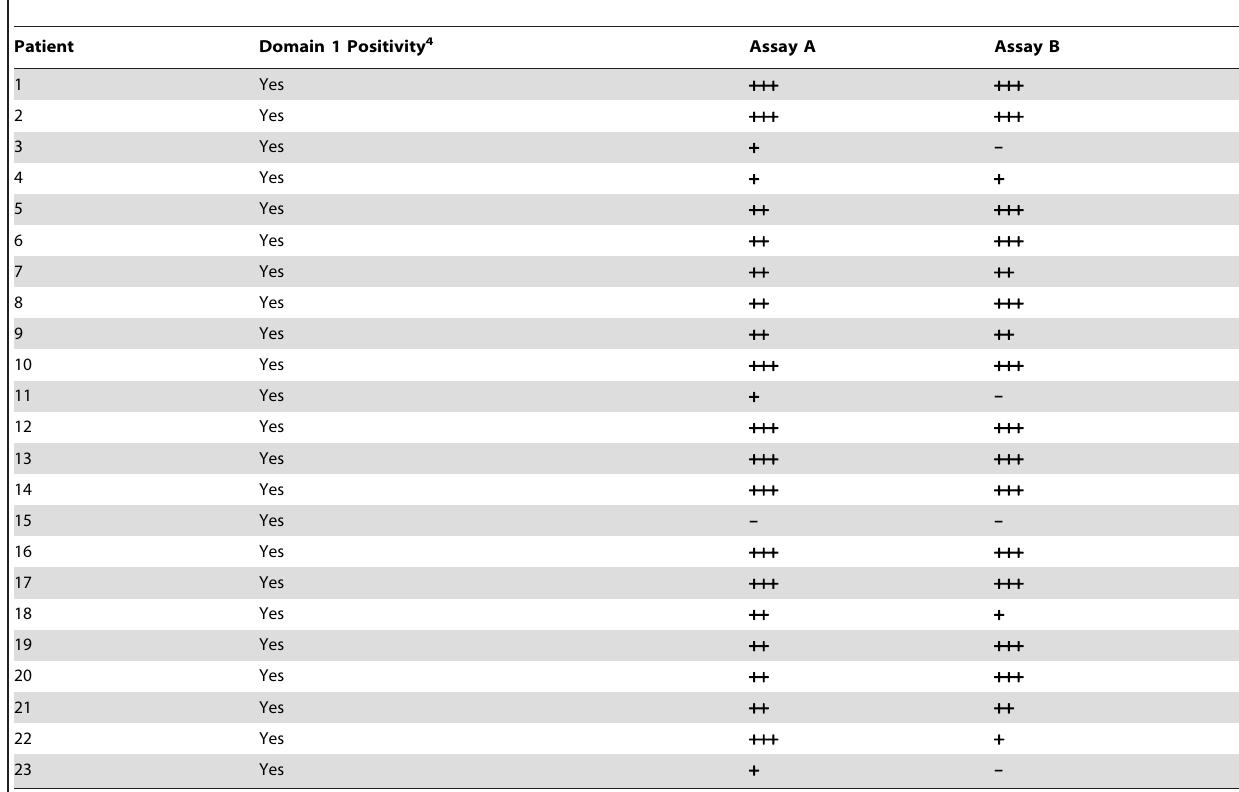
Table 4. Reactivity of SLE/APS patient samples from cohort 2 in two different anti- b 2 GPI assays.